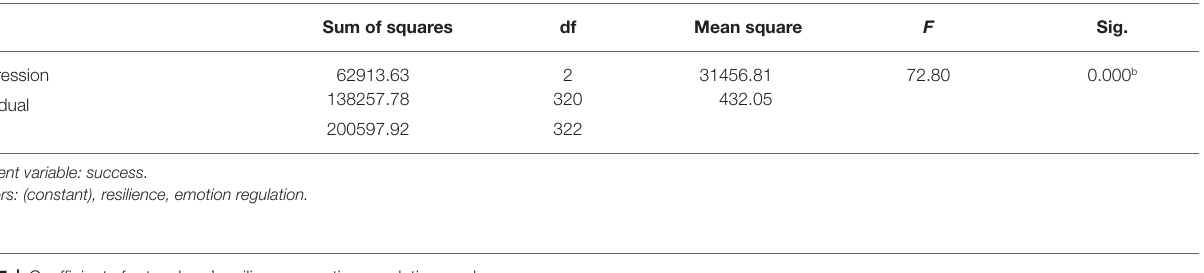
TABLE 7 | Coefficients for teachers’ resilience, emotion regulation, and success.